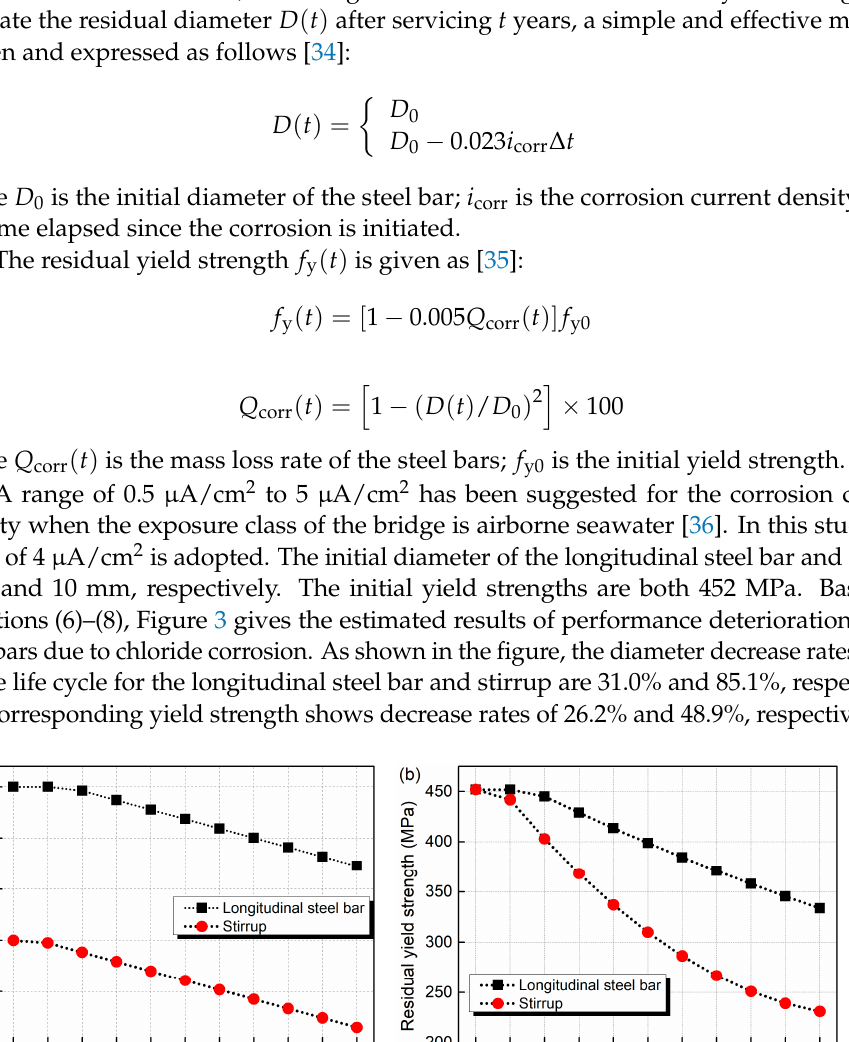
Figure 2. Corrosion initiation time of the longitudinal steel bar and stirrup.